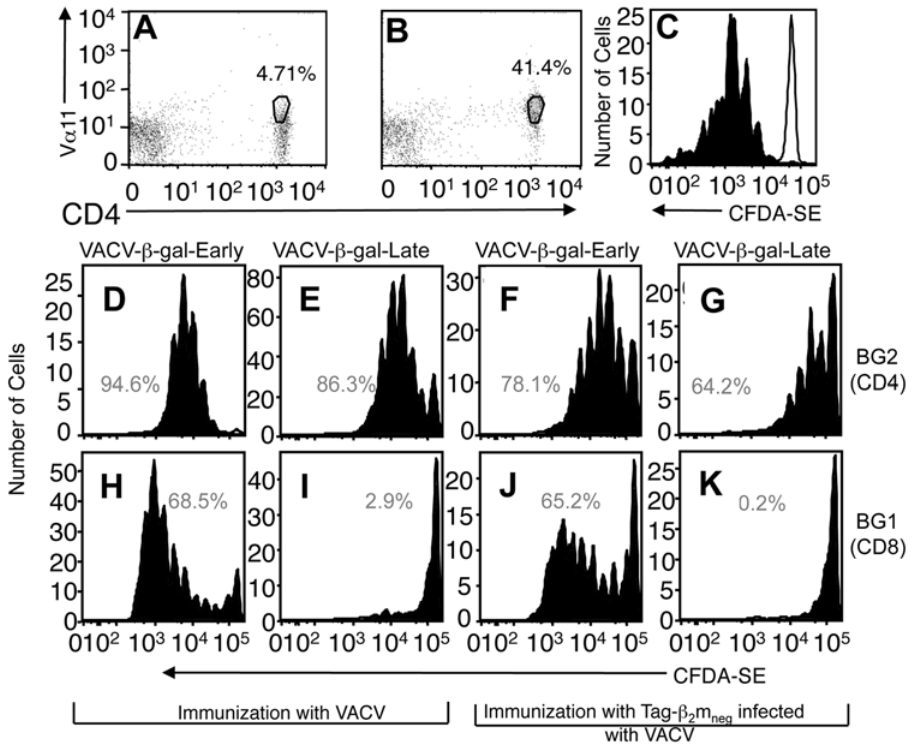
Figure 8. Sequestered antigen is not available for cross priming, but can be presented via the MHC Class II processing pathway. Expression of the V a 11 T cell receptor chain in T CD4 + from wild-type (A) or BG2.SJL (B) mice. (C) Division of adoptively transferred BG2.SJL T CD4 + following immunization with rVACV- b -gal-Early (black) or a VACV that does not express b -gal (white). Division of adoptively transferred b -gal-specific T CD4 + (D–G) or T CD8 + (H–K) following immunization with rVACV- b -gal-Early (D,H), rVACV- b -gal-Late (E,I), TAg- b 2 m neg cells infected with rVACV- b -gal- Early (F,J) or TAg- b 2 m neg cells infected with rVACV- b -gal-Late